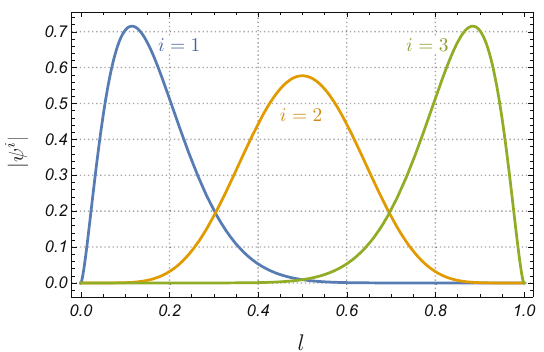
Figure 3 . Pro(cid:12)les of absolute values of spinor wavefunctions on the S 2 with two branes in terms of the modi(cid:12)ed l -coordinate. We set (cid:11) = 0 : 9 and qM = 27. The constant curvature is given as k = 1 (cid:11) so that the volume is normalized as (cid:0)